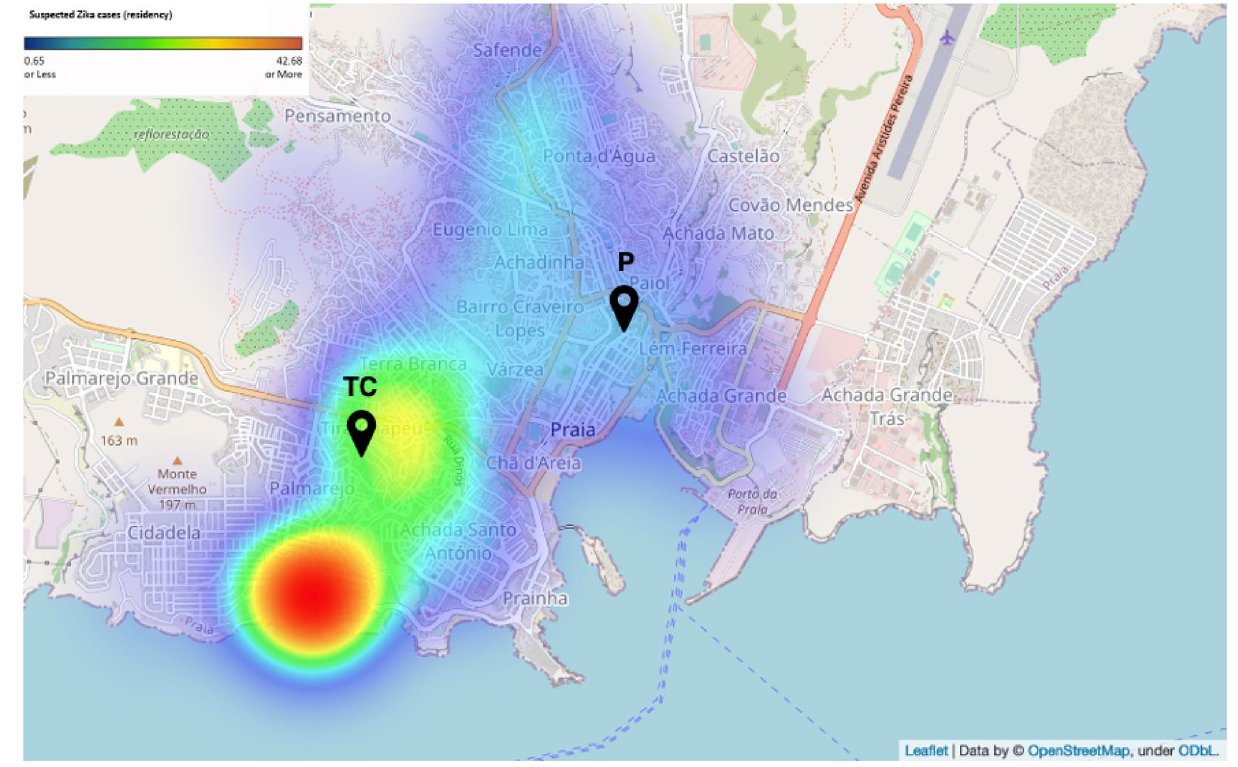
Figure 1. Geospatial distribution of suspected Zika infections in Praia, Cabo Verde. Data extracted and geocoded from the government’s surveillance programme. Cases recorded between October 2015 to April 2016. Collection centres in Praia indicated by TC (Tira Chapéu) and P (Praia). The map was generated by OpenStreetMap under ODbL and Folium (https:// python- visua lizat ion. github. io/ folium/).